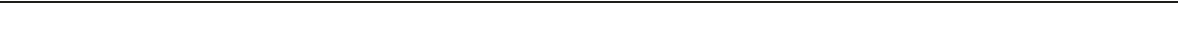
Fig. 9 The transcriptional signature of S + L + cells from healthy vessels is expressed in VSMC-derived plaque cells. a t-SNE visualisation of 10X Chromium dataset (3314 cells) of lineage-positive cells isolated from aortic plaques and the underlying media in Myh11-CreERt2/Confetti mice that were fi rst tamoxifen-treated and then fed a cholesterol-rich diet for 14 or 18 weeks (tissue from three and two animals respectively was pooled for the analysis). The cells are grouped into a large population composed of 9 clusters, including one enriched for chondrocytic genes (cluster 8, magenta), and a smaller, distinct population, which was enriched for macrophage genes (cluster 9, pink). b t-SNE plot of 10X Chromium dataset from a with Ly6a/Sca1 expression colour- coded from light to dark grey. c , d t-SNE plot of 10X Chromium from a , with expression scores for cVSMCpos ( c ) or cVSMCneg ( d ) genes colour-coded on a blue to red gradient. e Violin plots showing the expression score of cVSMCpos genes in cells mapping to each cluster shown in a . f Confocal image of a cryosection of the descending thoracic aorta from a Myh11-CreERt2/Confetti/ApoE -/- mouse fed a cholesterol-rich diet for 30 weeks and immunostained for Sca1. Signals for fl uorescent Confetti proteins (GFP, green; RFP, red; YFP, yellow and CFP, blue) are shown in i – iii, nuclear DAPI (white) is shown in all panels, and anti-Sca1 (magenta) is shown in i, ii, and iv. The region outlined in i is magni fi ed in ii – iv, with arrows pointing to cells that are double-positive for the Confetti lineage label (RFP) and Sca1. Image in i is a maximum projection of 16 z-slices (2 µ m each) and ii – iv show a single 2 µ m Z-slice. Scale bars are 40 μ m (i) or 15 μ m (ii – iv) NATURE COMMUNICATIONS| (2018) 9:4567 |DOI: